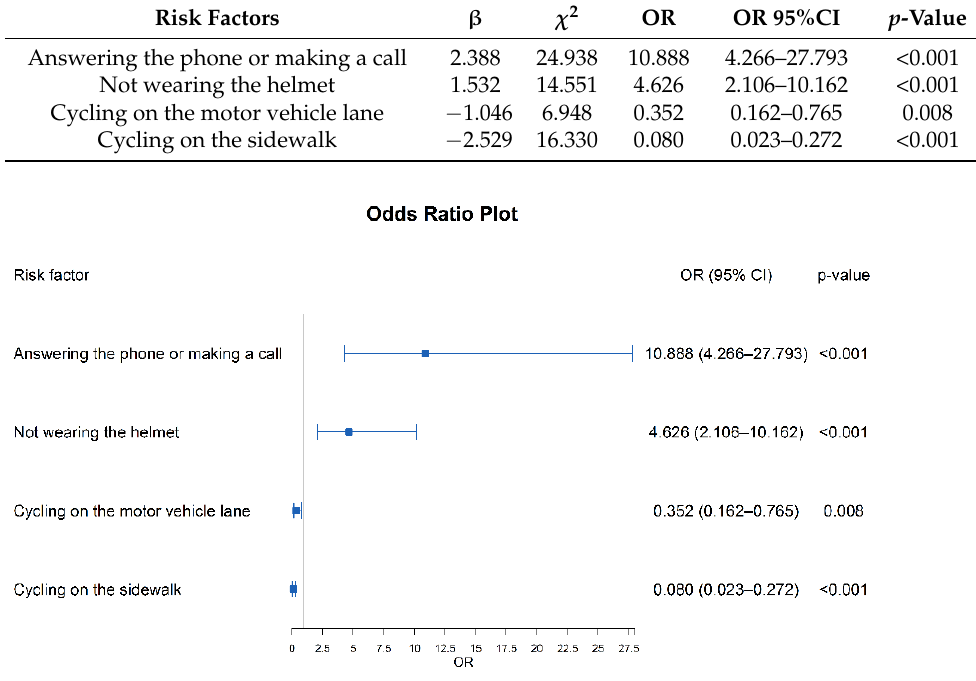
Figure 2. Forest plot of risk factors in the case-crossover study of ERTIs.